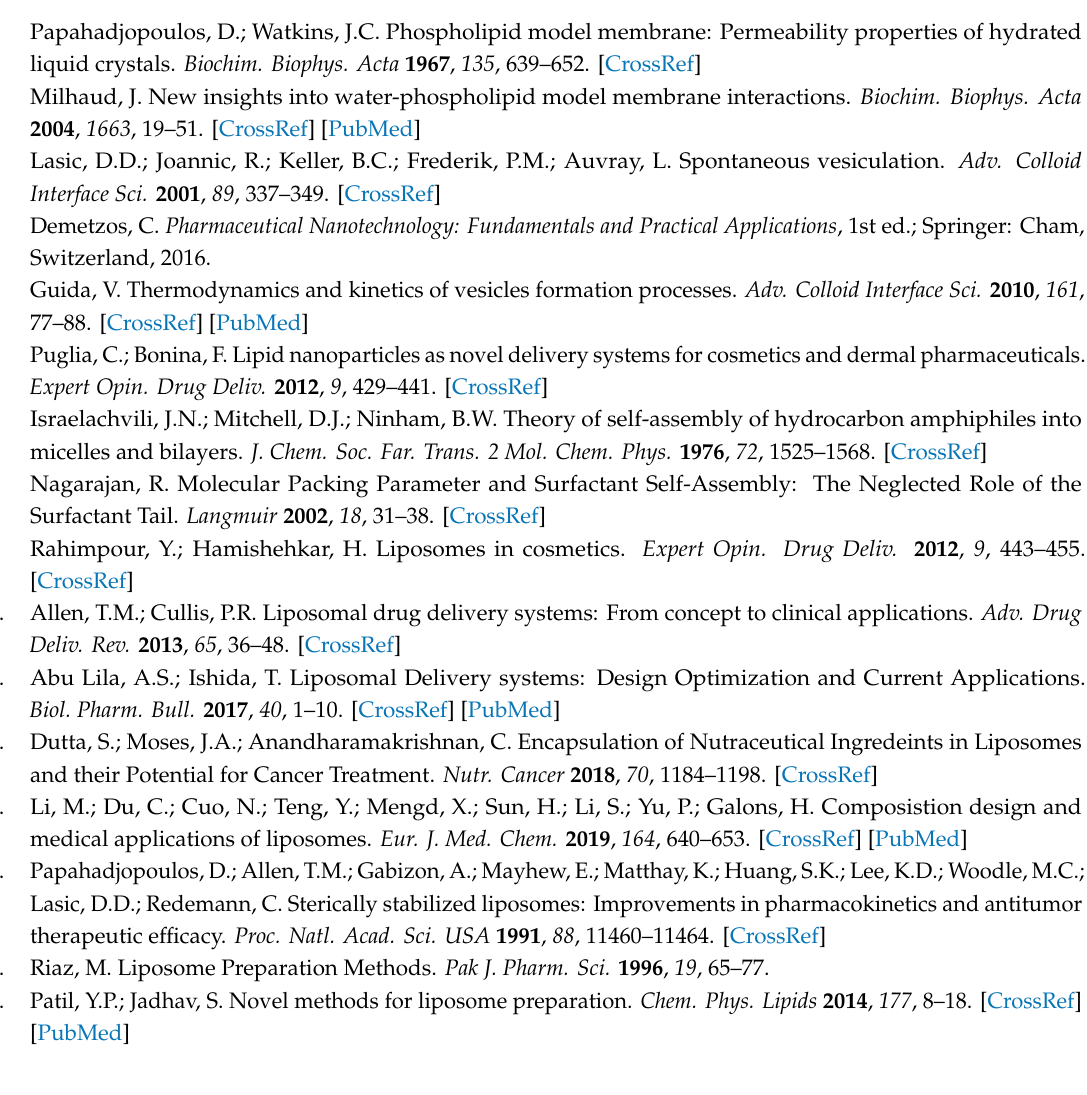
Figure S1: Distribution by (A) intensity (DI), (B) volume (DV) and (C) number (DN) of ( a ). HSPC:SA 9:0.25 and ( b ). EggPC:CHOL:SA 9:1.8:0.25 lipidic vehicles with glycerine concentration 20% v / v, built in Table 2.